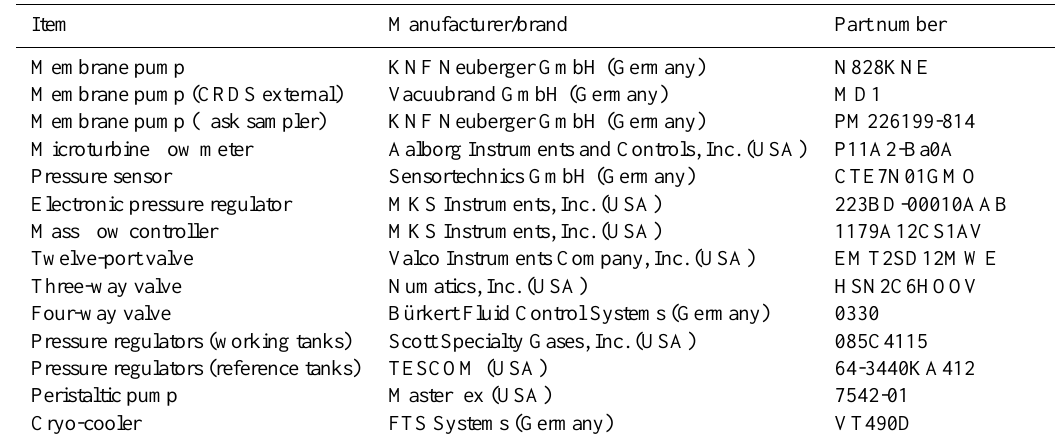
Figure 2. Diagram of the measurement system. Table 1. Part list of gas handling